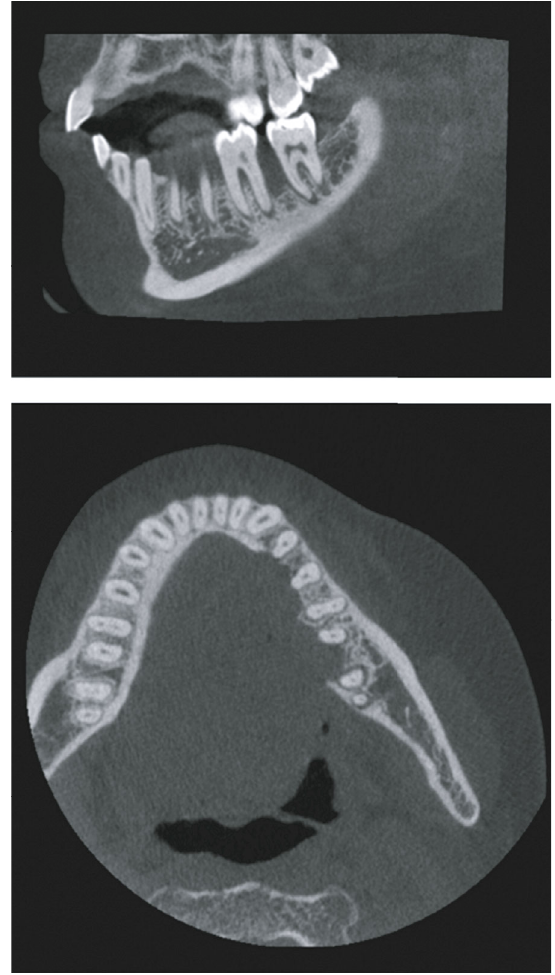
Figure 3: CBCT imaging of the lower jaw. Cortical bone destruction, a ff ecting the lingual cortex that extends from the canine up to the second molar, is